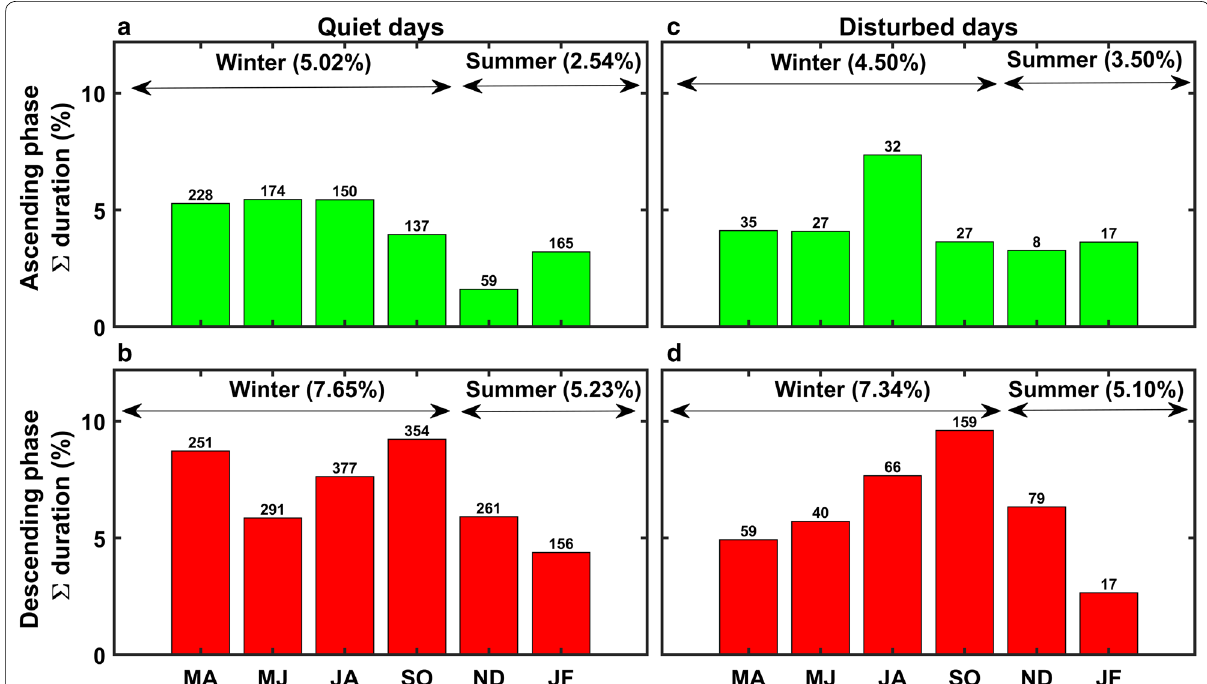
Fig. 5 Quiet time ( a , b ) and disturbed time ( c , d ), respectively, represent the seasonal percentage occurrence of EMIC waves for ascending (upper panels) and descending (lower panels) phases of the solar cycle. The duration of EMIC wave occurrence falling under each category is mentioned on each bar (in